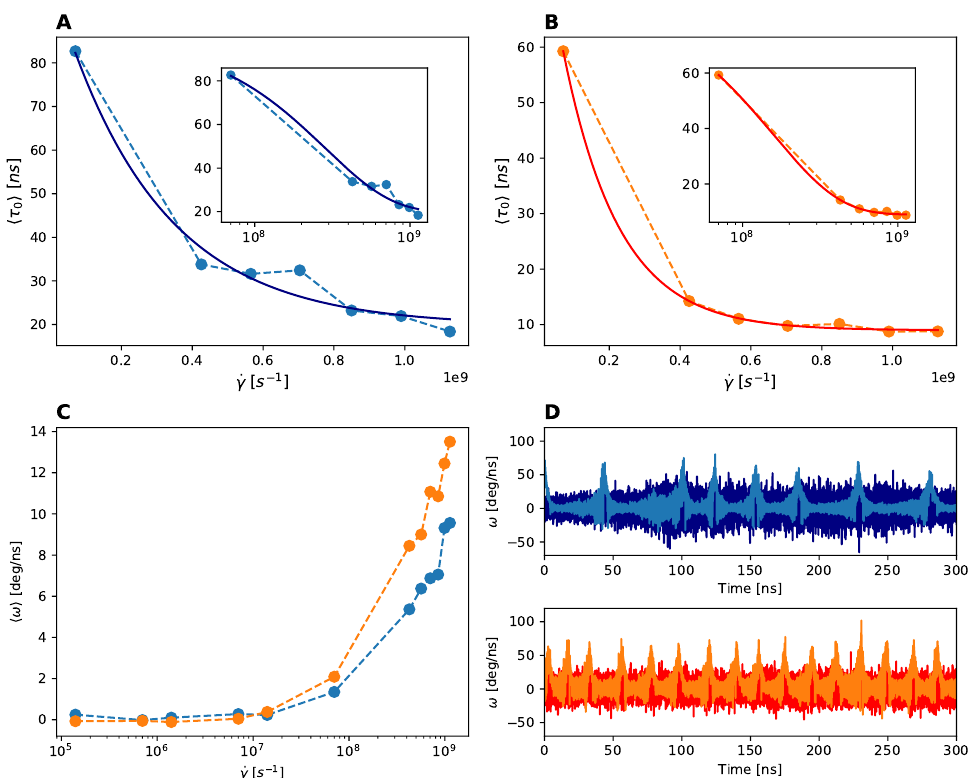
Figure 9. Rotational dynamics. Panels ( A , B ). Characteristic rotational time of the A1 (left panel) and A3 (right panel) domains with respect to the central A2 domain as a function of the simulated shear rates ˙ γ . In the inset the data are represented in log-x scale for shear rates values ˙ γ > 10 7 s − 1 . Panel ( C ). Angular velocity computed for the A1 (blue) and A3 (orange) domain rotation relative to A2 as a function of the shear rate. Panel ( D ). Time evolution of the angular velocity for the A1 (top) and A3 (bottom) domains, for two shear rates ˙ γ = 8.5 × 10 8 s − 1 (light blue and orange) and ˙ γ = 1.4 × 10 5 s − 1 (dark blue and